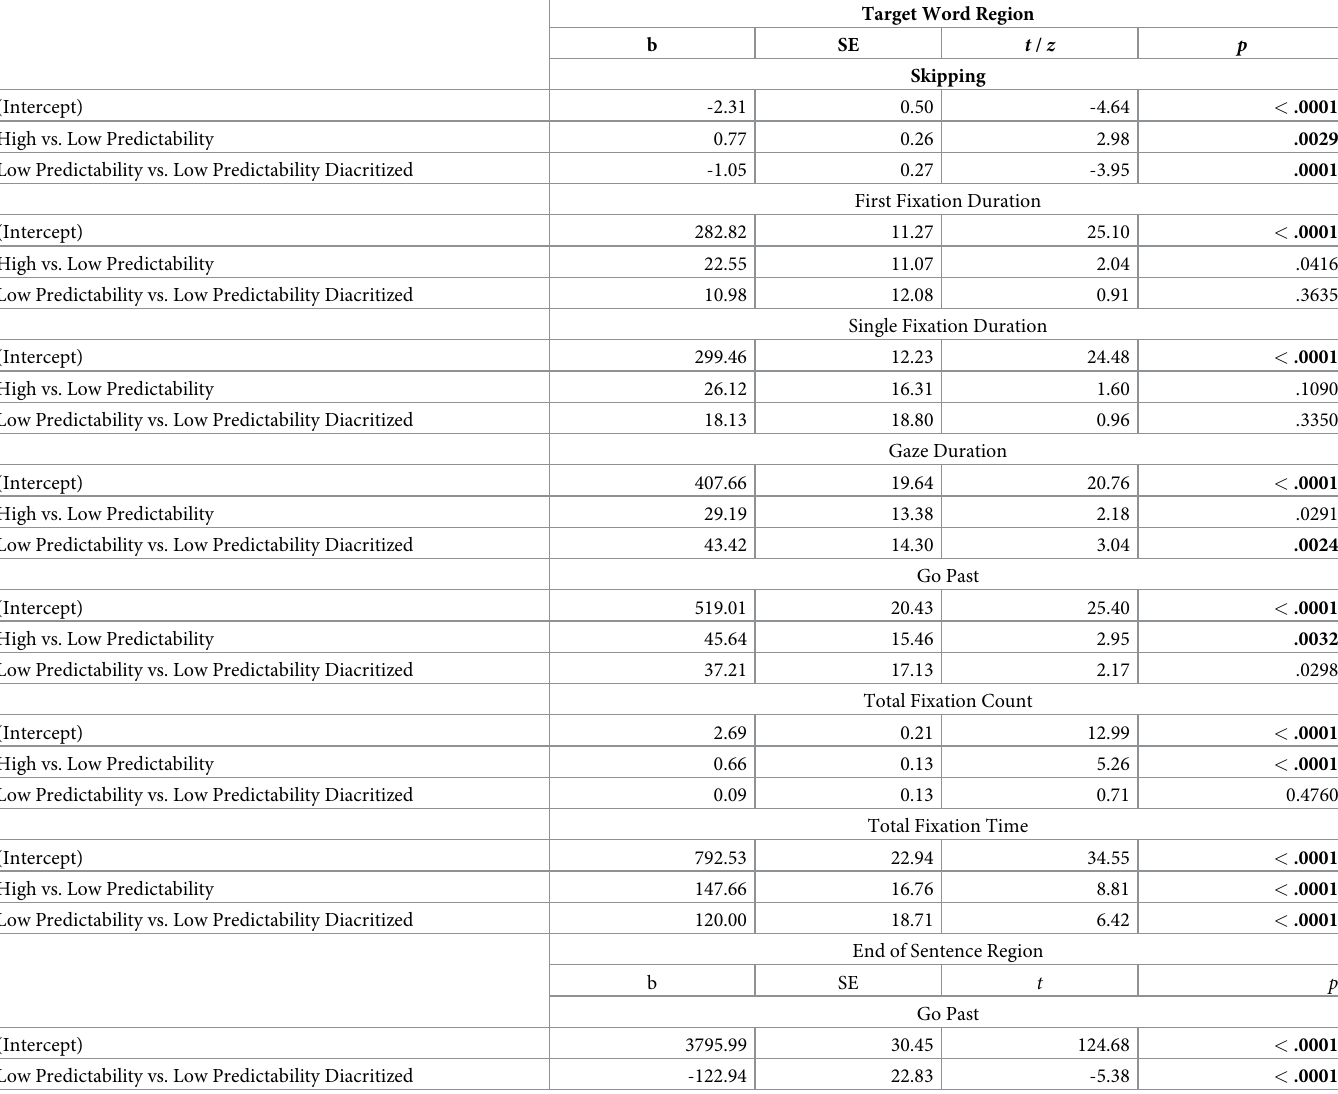
Table 6. GLMM output for eye movement measures (experiment 3 –word predictability and